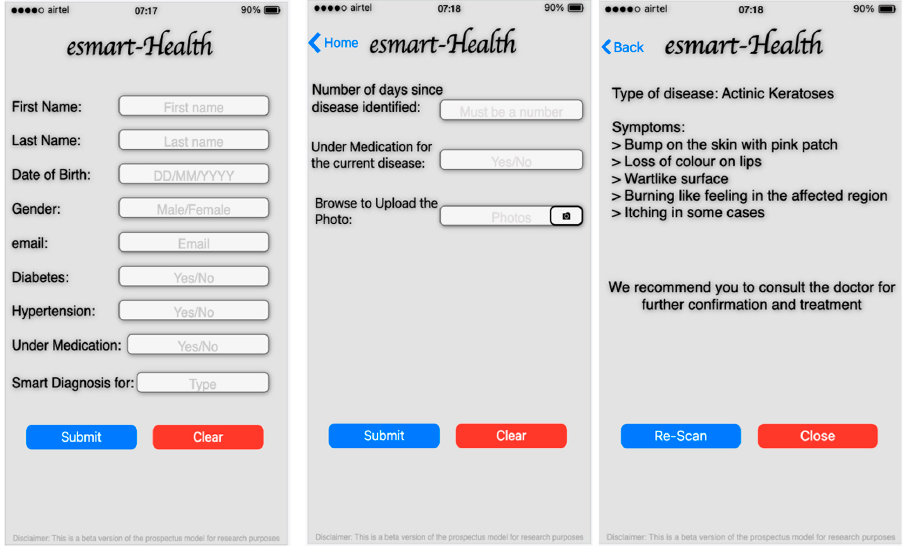
Figure 16. The interface of the mobile application to gather user’s data and prediction result interface of mobile application.